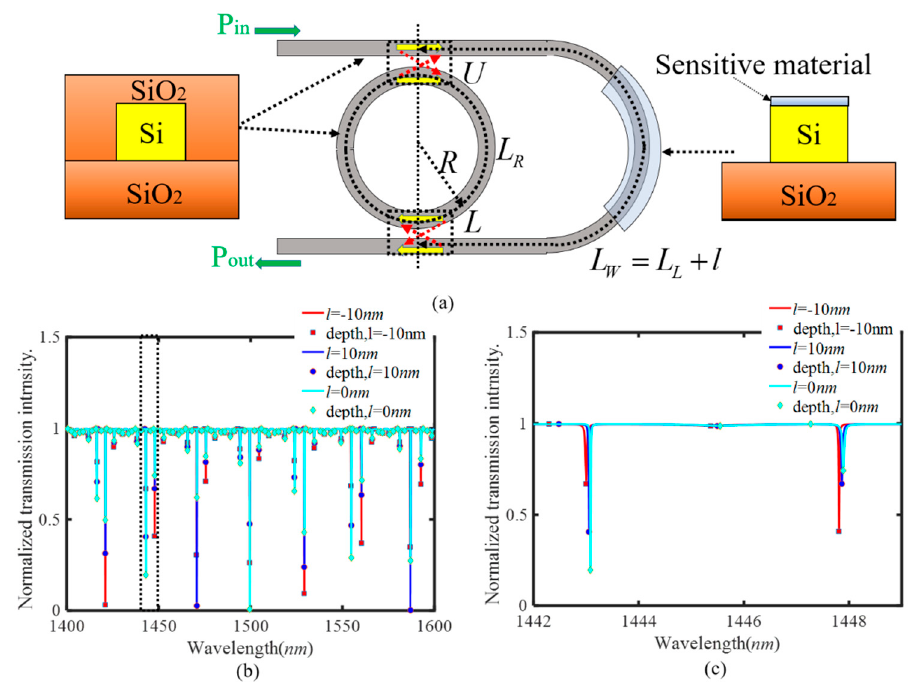
Figure 1. Multimode sensing mechanism by SIMRR (self-interference micro-ring resonator). ( a ) Structural diagram of SIMRR and its sensor design. ( b ) The simulated transmission spectra in the wavelength range of 1400–1600 nm for the cases of the length change of sensing arm waveguide l = − 10, 0, 10 nm. ( c ) Enlarged diagram of dotted area in (b).